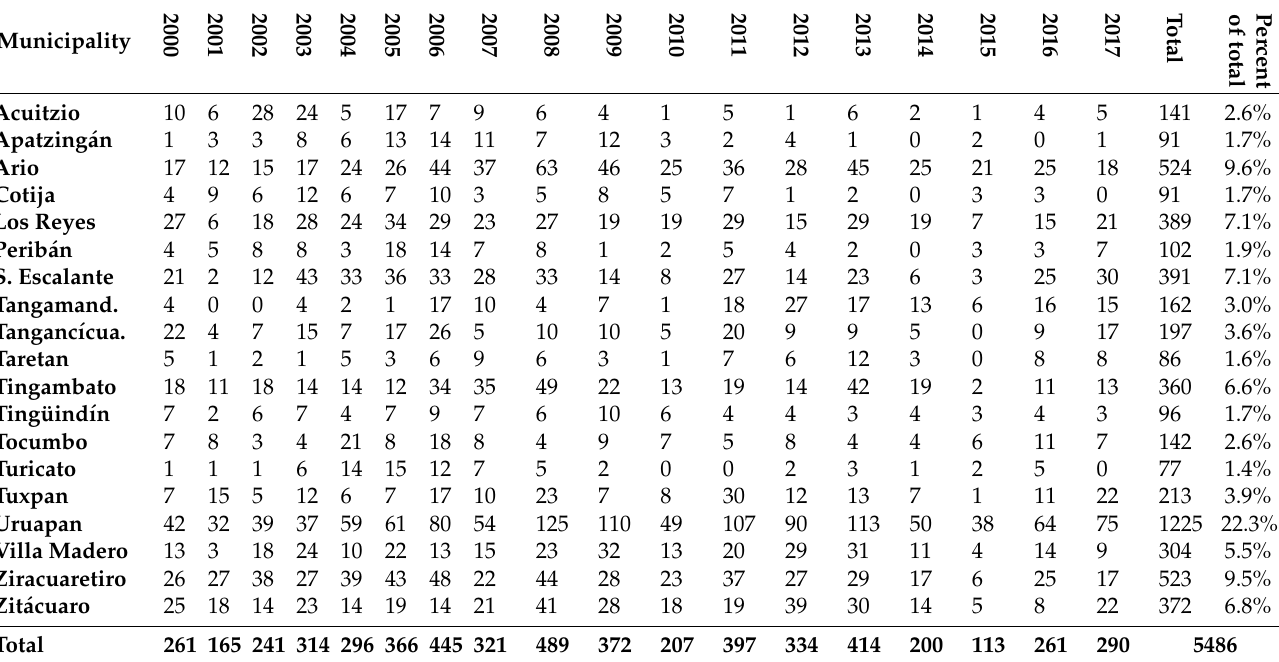
Table A2. The annual number of fires per municipality in the 2000–2017 period.